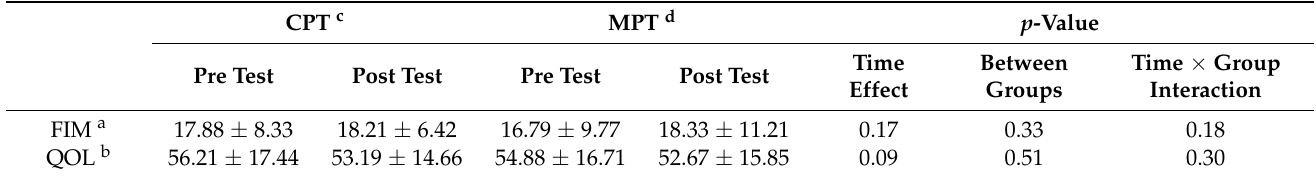
Table 4. Functional independence measure and quality of life.